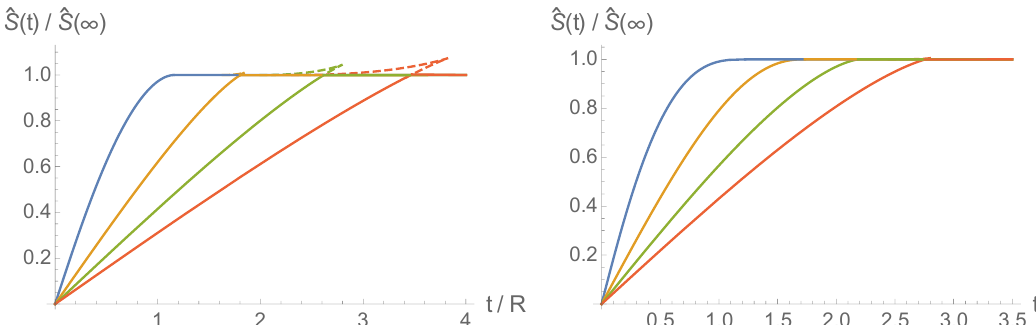
Figure 9. Entanglement growth from d = 3 ; 4 RN black branes with q = 0 ; 1 = 2 ; 2 = 3 ; 3 = 4 plot- ted with blue, orange, green, and red respectively. To obtain these curves we numerically inte- grated (4.18). The irrelevant parts of the curves ( (cid:28) ( r (cid:3) ) ; ( r (cid:3) )) are drawn with dashed lines. Left: A in d = 3 saturation is always discontinuous, but in the q = 0 case to see the cuspy behavior visible for larger q requires extreme numerical precision as discussed in section 4.4. Right: in d = 4 for q = 0 ; 1 = 2 saturation is continuous, and discontinuous for q = 2 = 3 ; 3 = 4, but the dashed parts of the curves are hardly